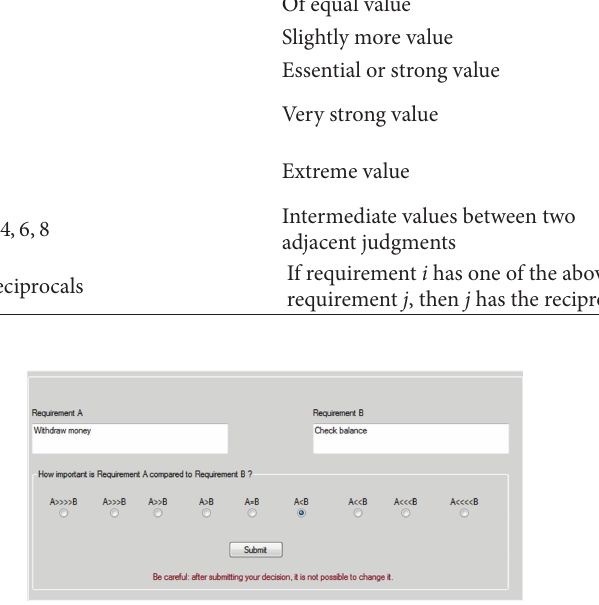
Figure 4: A snapshot of the graphical user interface showing a pair of requirements (withdraw money, check balance) under evaluation in